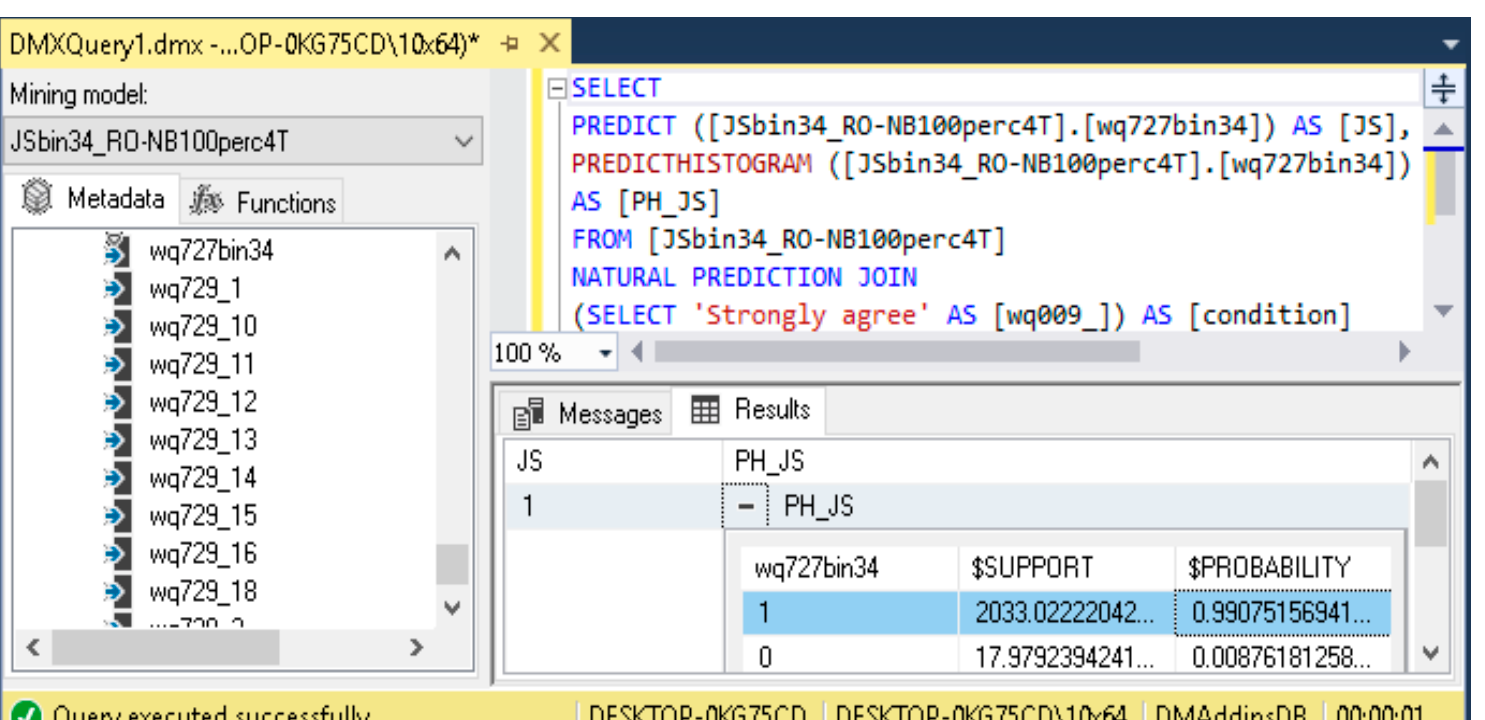
Figure A1. Example of a SQL DMX query to explore a naive Bayes based DM model in the first round mining.